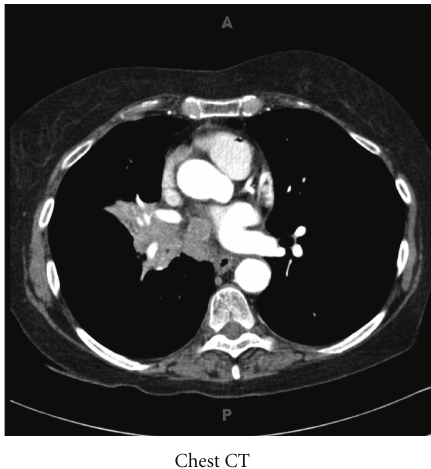
Figure 2: Chest CT: 6cm right infrahilar mass with involvement of the subcarinal and paraesophageal